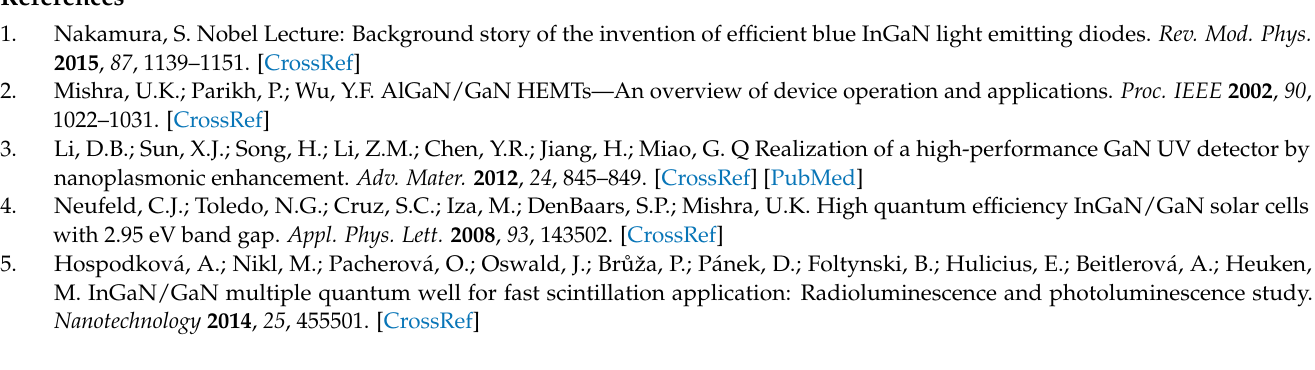
Figure S2: Results of decompositions of positron lifetime spectra for the sample TEN2 plotted as a function of the energy of incident positrons. Figure S3: Results of decompositions of positron lifetime spectra for the sample TEN3 plotted as a function of the energy of incident positrons. Figure S4: Results of decompositions of positron lifetime spectra for the sample TEH1 plotted as a function of the energy of incident positrons. Figure S5: Results of decompositions of positron lifetime spectra for the sample TEH2 plotted as a function of the energy of incident positrons. Figure S6: Results of decompositions of positron lifetime spectra for the sample TEH3 plotted as a function of the energy of incident positrons. Figure S7: Results of decompositions of positron lifetime spectra for the sample TMN1 plotted as a function of the energy of incident positrons. Figure S8: Results of decompositions of positron lifetime spectra for the sample TMN2 plotted as a function of the energy of incident positrons. Figure S9: Results of decompositions of positron lifetime spectra for the sample TMN3 plotted as a function of the energy of incident positrons. Figure S10: Results of decompositions of positron lifetime spectra for the sample TMH1 plotted as a function of the energy of incident positrons. Figure S11: Results of decompositions of positron lifetime spectra for the sample TMH2 plotted as a function of the energy of incident positrons. Figure S12: Results of decompositions of positron lifetime spectra for the sample TMH3 plotted as a function of the energy of incident positrons. References [35,36] are cited in the supplementary